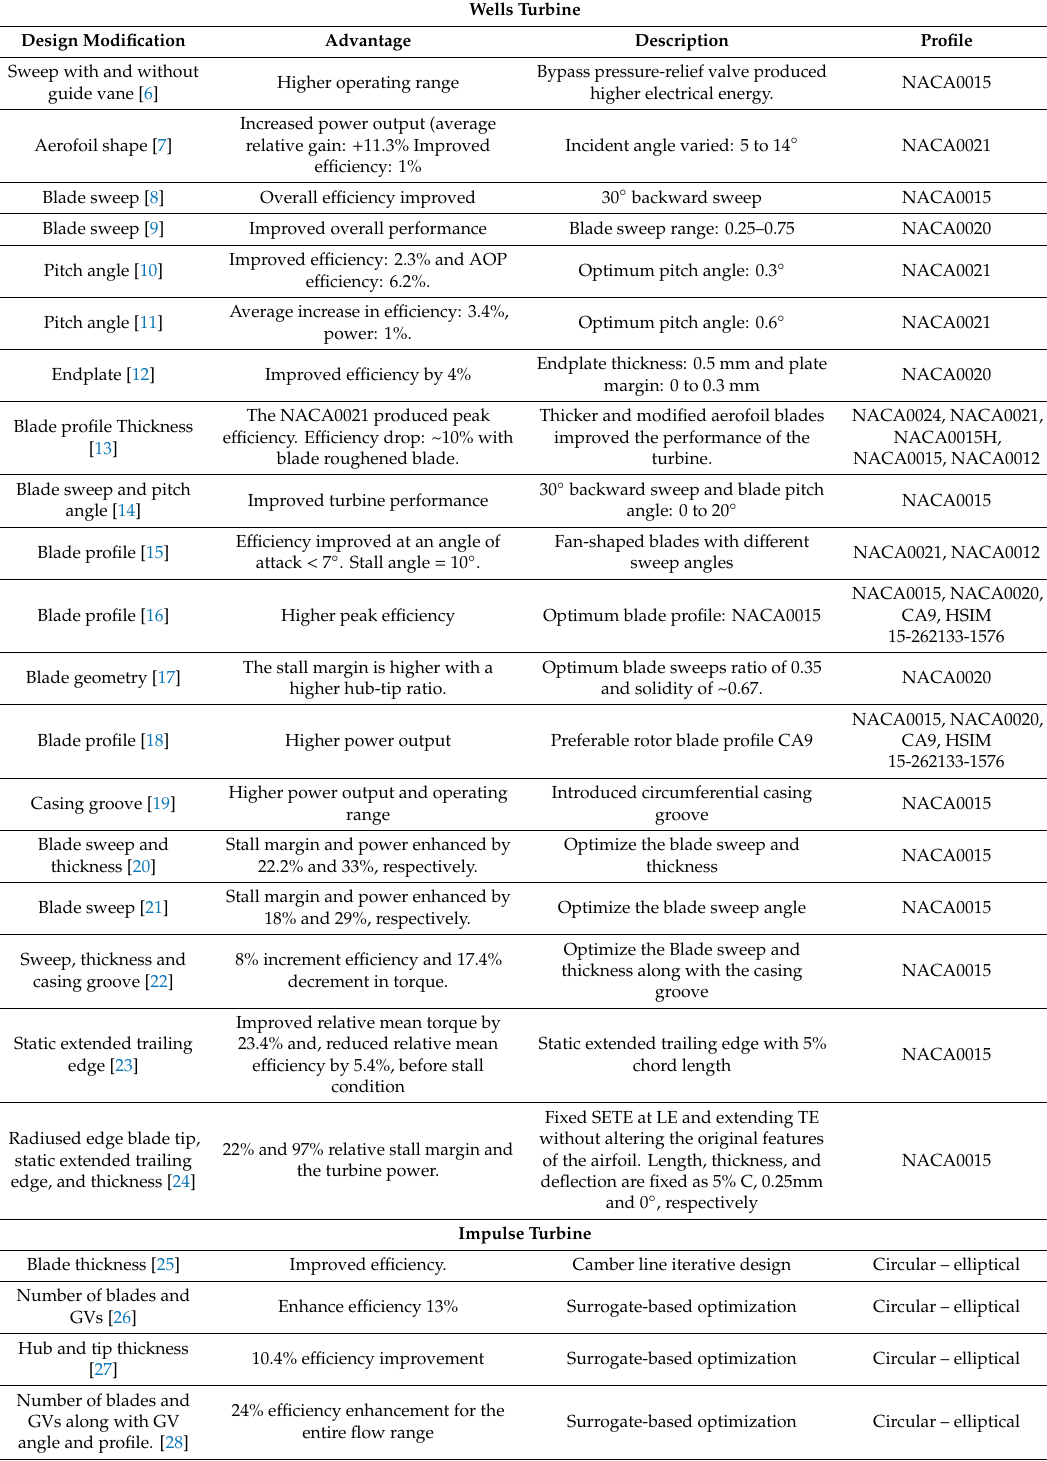
Table 1. Some prominent studies of Wells and Impulse turbines for wave energy